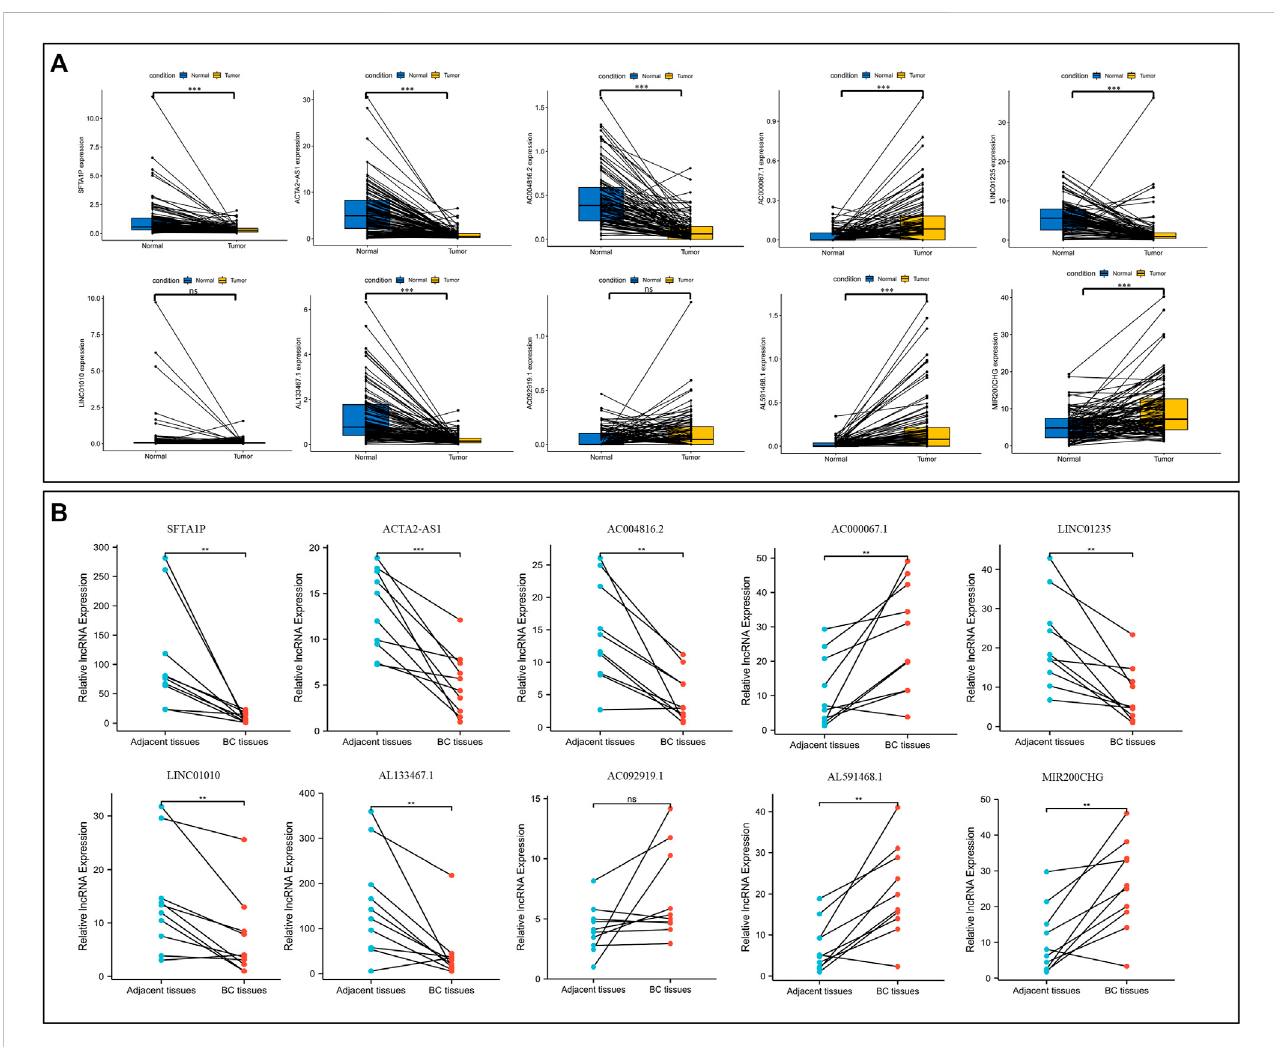
FIGURE 11 Validation the expression level of NETs-related lncRNAs. (A) The differential expression of 10 NETs-related lncRNAs between tumors and their matched benigntissueinTCGARNA-seqdata. (B) Theexpressionlevelsof10NETs-relatedlncRNAsin10pairedsamplesofBCtumorandadjacentnormaltissueswere examinedbyqRT-PCR.ns,notsigni fi cant,* p < 0.05,** p < 0.01,*** p < 0.001.NETs,neutrophilextracellulartraps;lncRNAs,longnon-codingRNAs;BC,breast